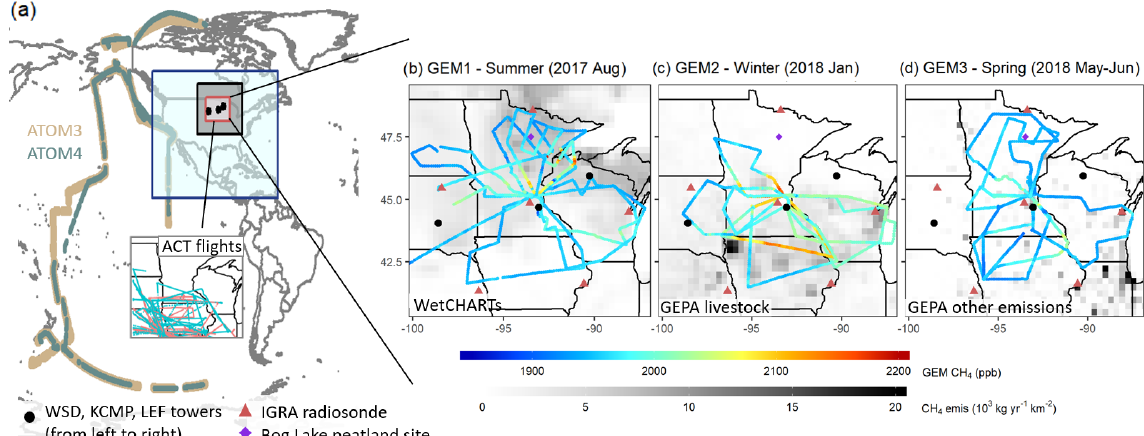
Figure 1. GEM flight tracks and additional datasets used in this study. Panel (a) shows Pacific flight tracks for the ATom3 and ATom4 campaigns used for evaluating modeled boundary and initial conditions. Also shown are the ACT-America flight tracks (C130 in cyan, B200 in red) used here for posterior model evaluation. The inner red box (40–50 ◦ N, 87–100 ◦ W) shows the GEM flight region that is expanded in (b–d) , the black box (35–55 ◦ N, 80–105 ◦ W) shows the Upper Midwest analysis region employed for source inversions, and the blue box (9.75–60 ◦ N, 60–130 ◦ W) demarks the GEOS-Chem nested North American domain. The right panels show the GEM flight tracks colored by observed methane mixing ratios and superimposed on the prior annual bottom-up emissions described in-text. Also shown are locations for the radiosonde launches and tall towers employed here, along with the Bog Lake peatland eddy flux